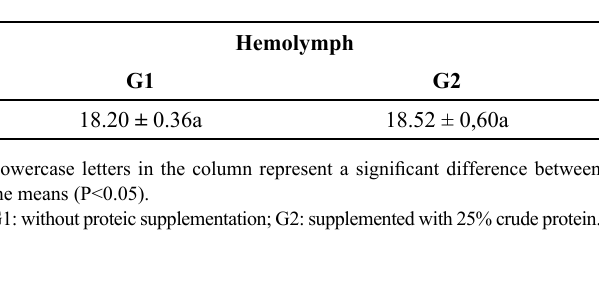
Table 3 . Protein content in hemolymph of nursing honeybees Apis mellifera Africanized supplemented or not with 25% of crude